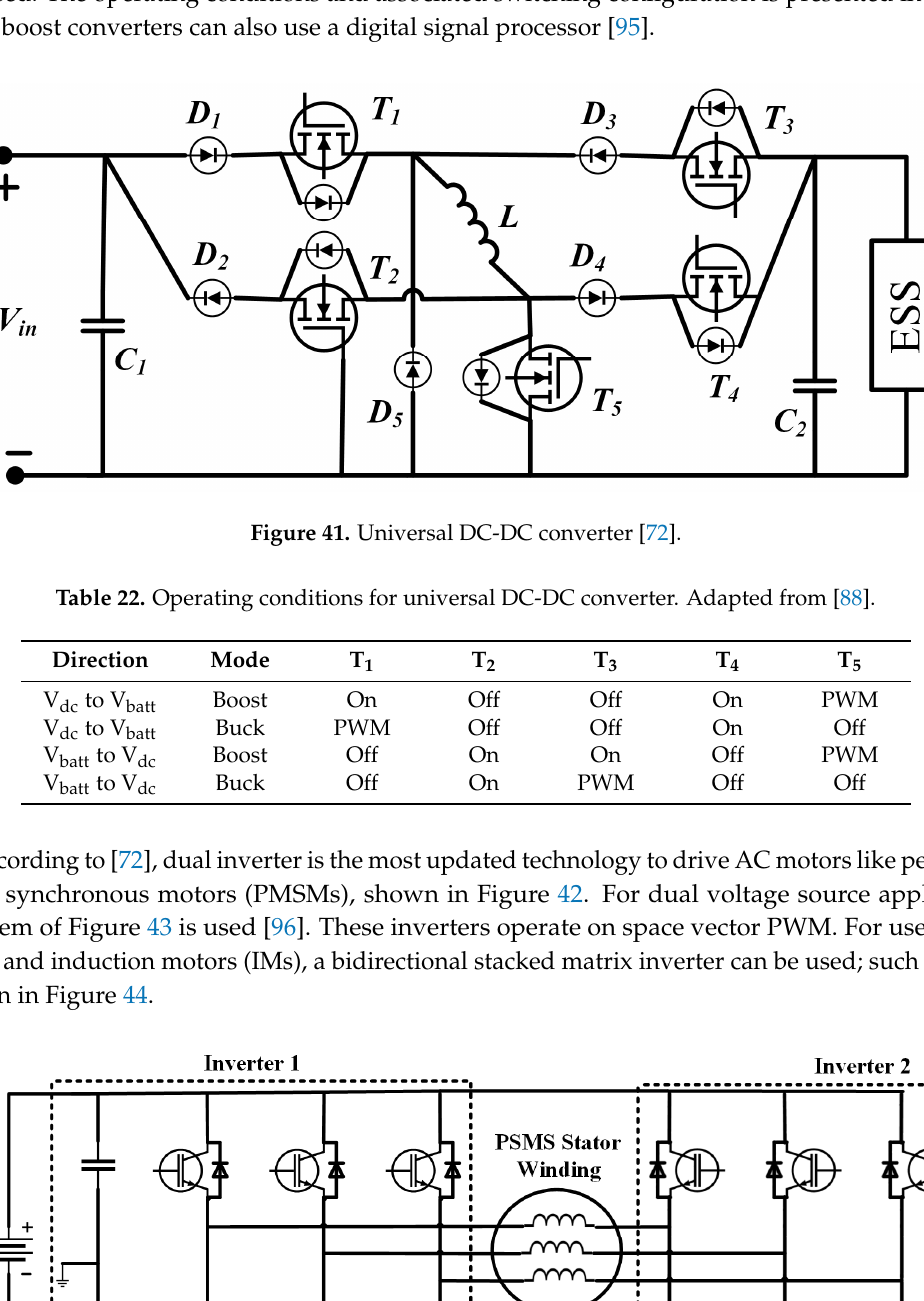
Figure 42. Dual inverter for single source [72].